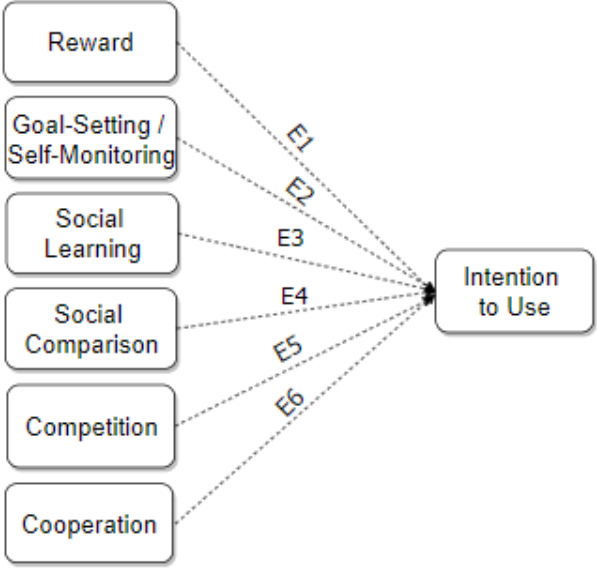
Figure 3. Research model of intention to use a fitness app.